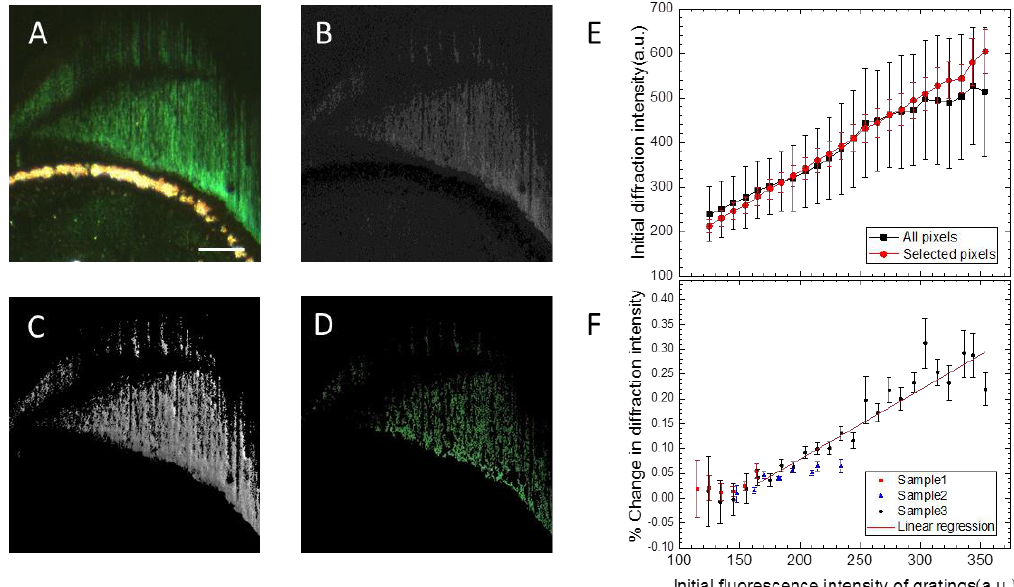
Figure 5. Image analysis reveals a stronger signal in pixels with color ratios consistent with Bragg diffraction and gratings with larger aspect ratios. ( A ) The initial diffraction image of a heterogeneous lipid multilayer grating. ( B ) The result of dividing the green-channel image of ( A ) by its red-channel image. As a result, the region of interest of the green diffraction intensity is identified. ( C ) The image of the green channel with the region of interest from ( B ) is divided by its fluorescent image. This ratio is used as a criterion for selecting pixels. ( D ) The final area is selected if it is within one standard deviation of the average green:red ratio from ( C ). ( E ) The graph shows the diffraction intensity as a function of its initial fluorescence intensity between selected pixels and all available pixels, indicating that grating lines with a larger height show a larger initial diffraction intensity. ( F ) Plots of the percentage of change in diffraction intensity response 5 min after the addition of thrombin among 3 different samples. This indicates that the signal is stronger in gratings with a larger height.